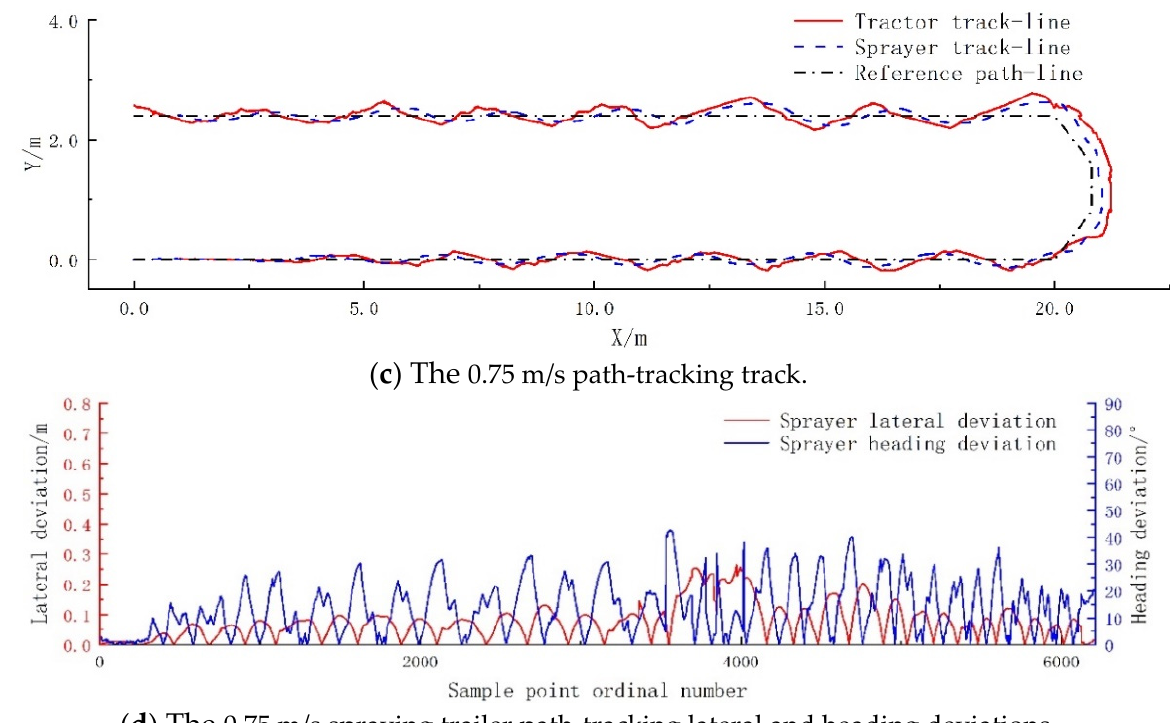
( b ) The 0.36 m/s spraying trailer path-tracking lateral and heading deviations.